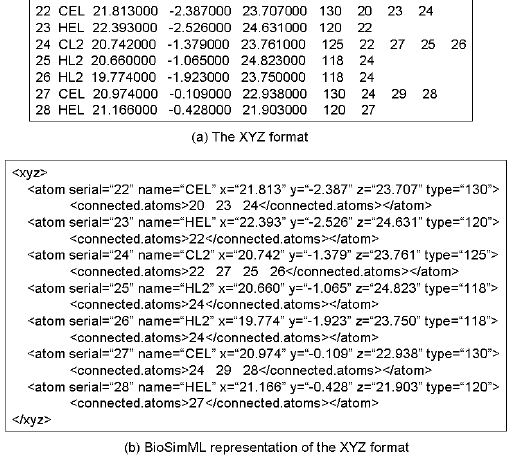
Figure 2: The arachidonic acid described in the XYZ format and the BioSimML representation In the XYZ format in Figure 2(a), the data fields from left to right are atom serial number, atom name, Cartesian coordinates ( x , y , and z ), atom type number, and a list of atoms connected